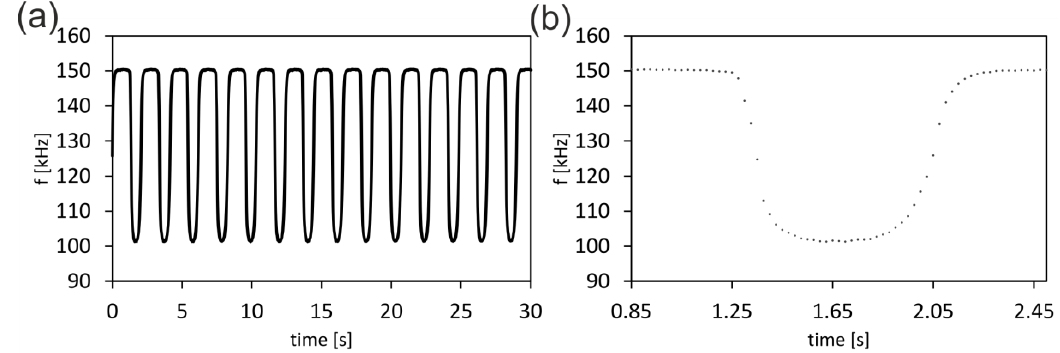
Figure 5. Sensor performance and response time. ( a ) Alternating droplets of conducting fluid (water) and nonconducting fluid (FC-40) were passed over the sensing electrodes. The electrodes detected the change in conductivity, resulting in a change of the charge and discharge time of the capacitor, which is displayed as a change in the corresponding frequency. The battery-operated microcontroller ensures a quick and stable readout of the alternating conductivity over 100 min at 2 mA discharge current. ( b ) Sensor response time: Close-up of the detected frequency change. The sensor detects the change between the two fluids in less than 0.4 s.